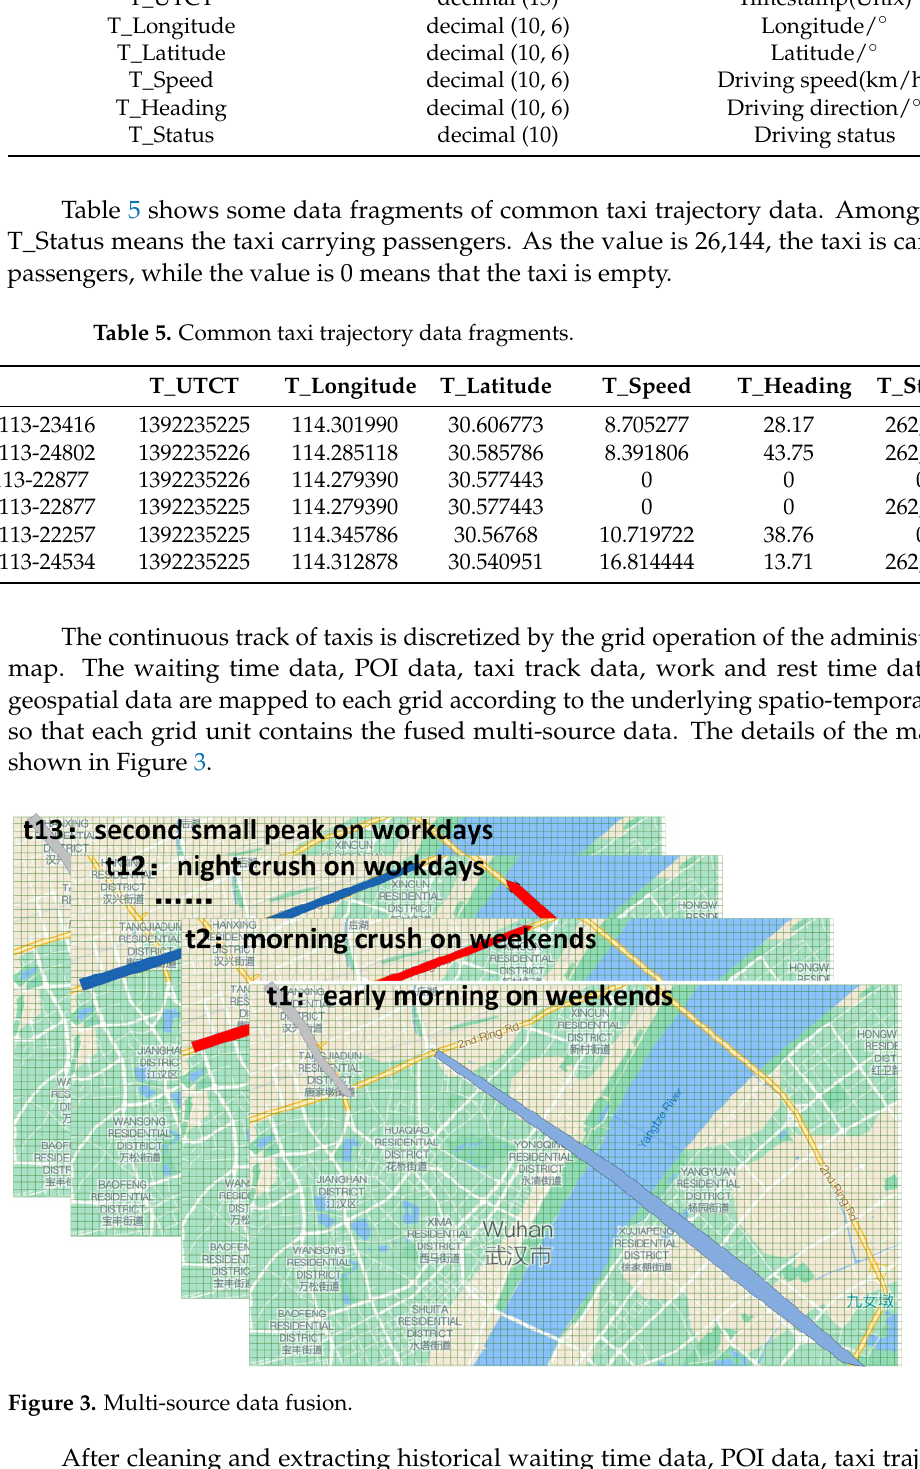
Weather Data Figure 4. Multi ‐ source data fusion method.